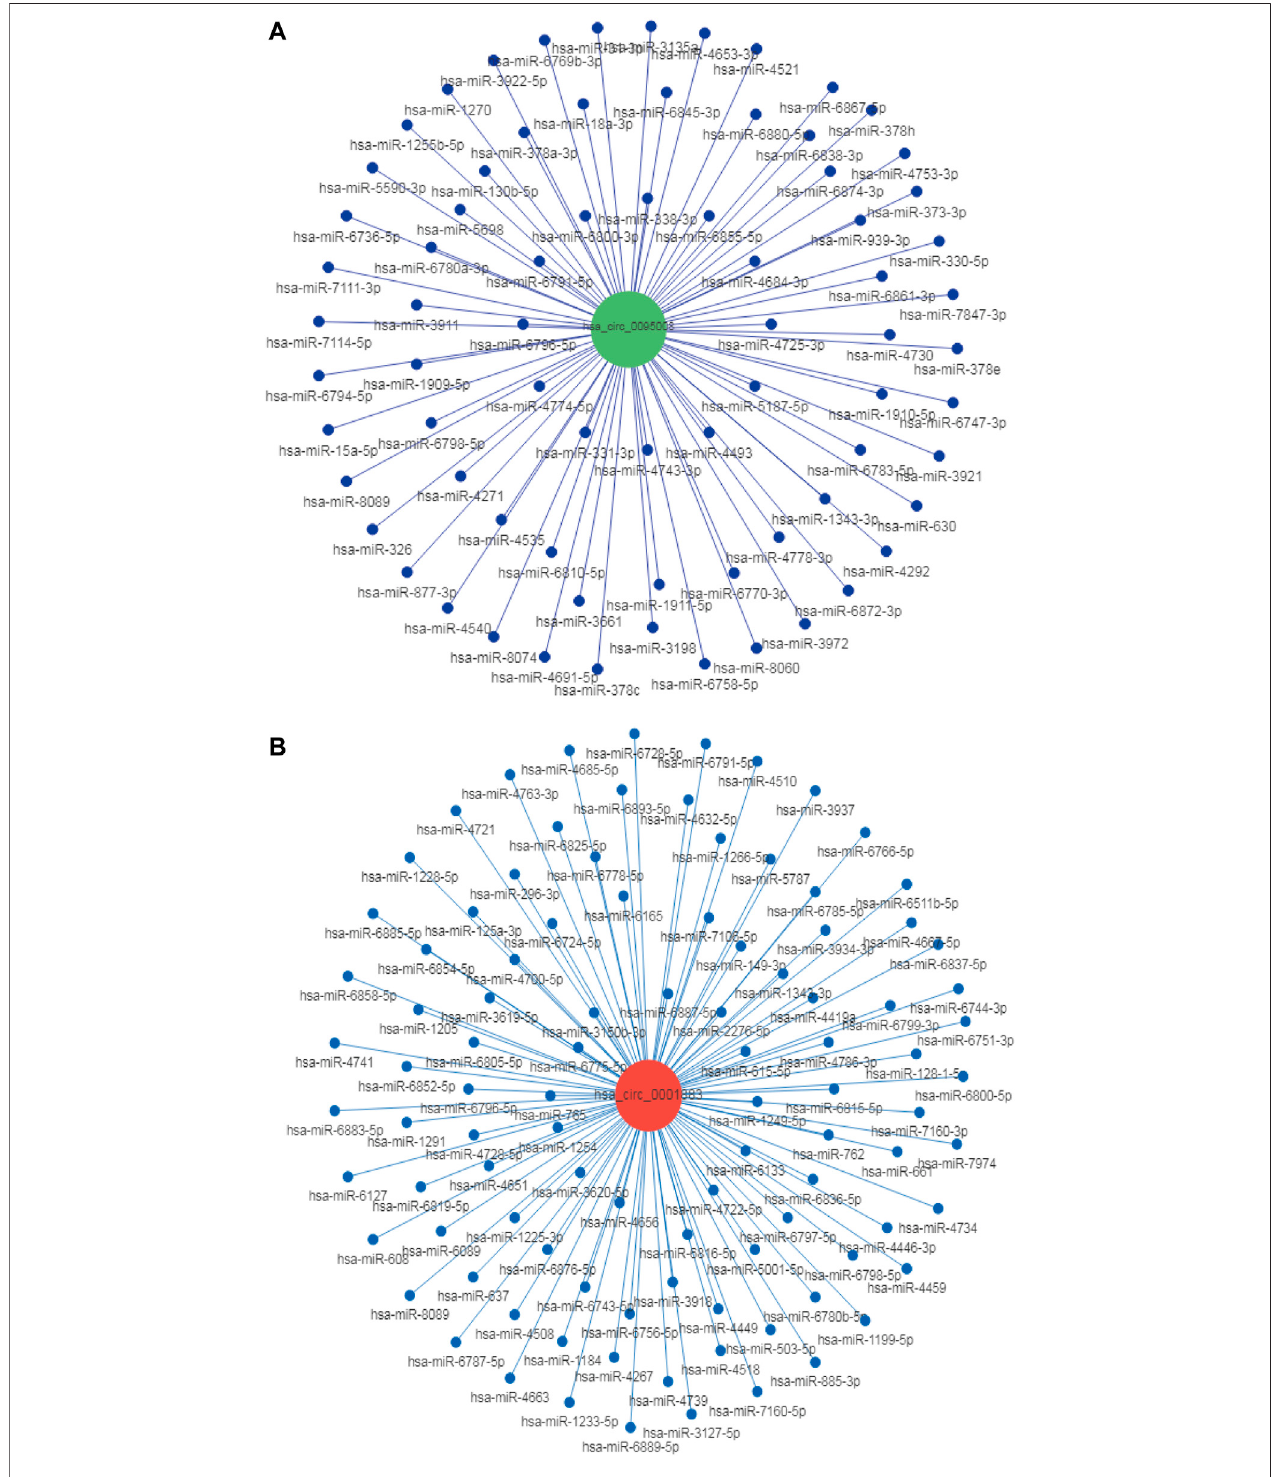
FIGURE 6 | Target miRNA prediction of hsa_circ_0095008 and hsa_circ_0001883 in DR samples. The CircRNA/miRNA regulatory networks of (A) hsa_circ_0095008 and (B) hsa_circ_0001883 were predicted by miRanda- 3.3 software.The red and blue dots represent circRNAs and miRNAs, respectively.